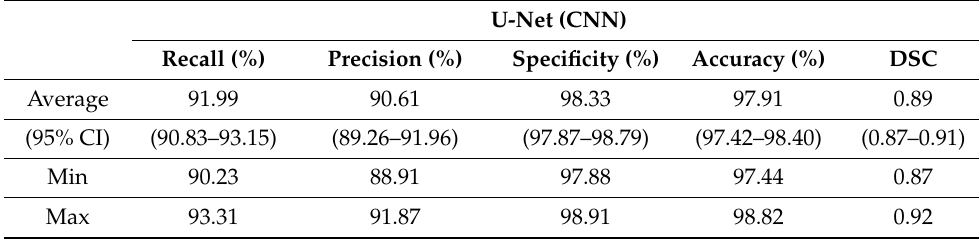
Table 1. Mean values of U-net performance in reconstructing the rib regions of